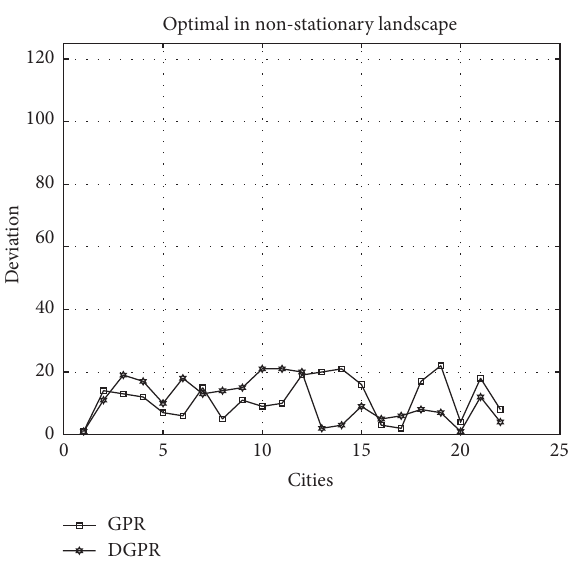
Figure 5: Minimum path generated by